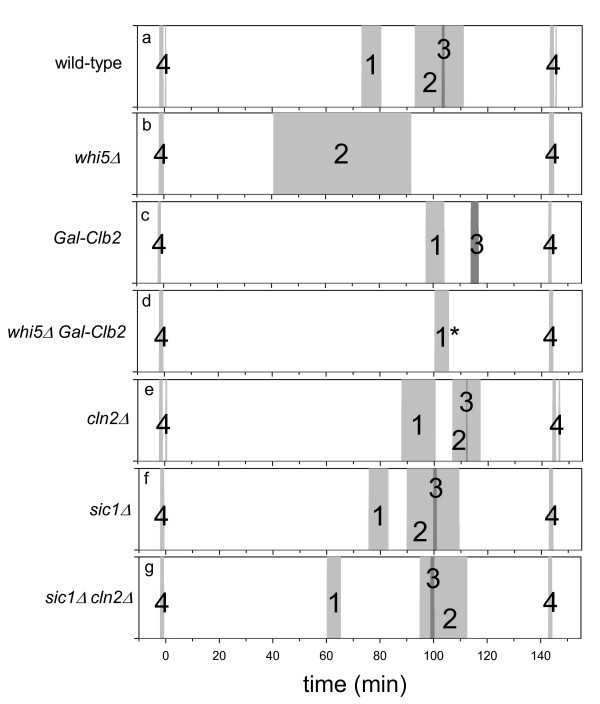
Positive eigenvalue periods in mutant cells. (a) wild-type (same as Fig 2); (b) whi5Δ (parameter changes: kisbf' = 0, kisbf" = 0); (c) Gal-Clb2 (ksb2' = 0.15); (d) whi5Δ Gal-Clb2 (see changes above); (e) cln1Δ cln2Δ (ksn2" = 0); (f) sic1Δ (ksc1' = 0, ksc1" = 0); (g) cln1Δ cln2Δ sic1Δ (see changes above). Excitation periods are labeled with same numbers as on Fig. 2 (1* stands for a new START related excitation period, details in text).